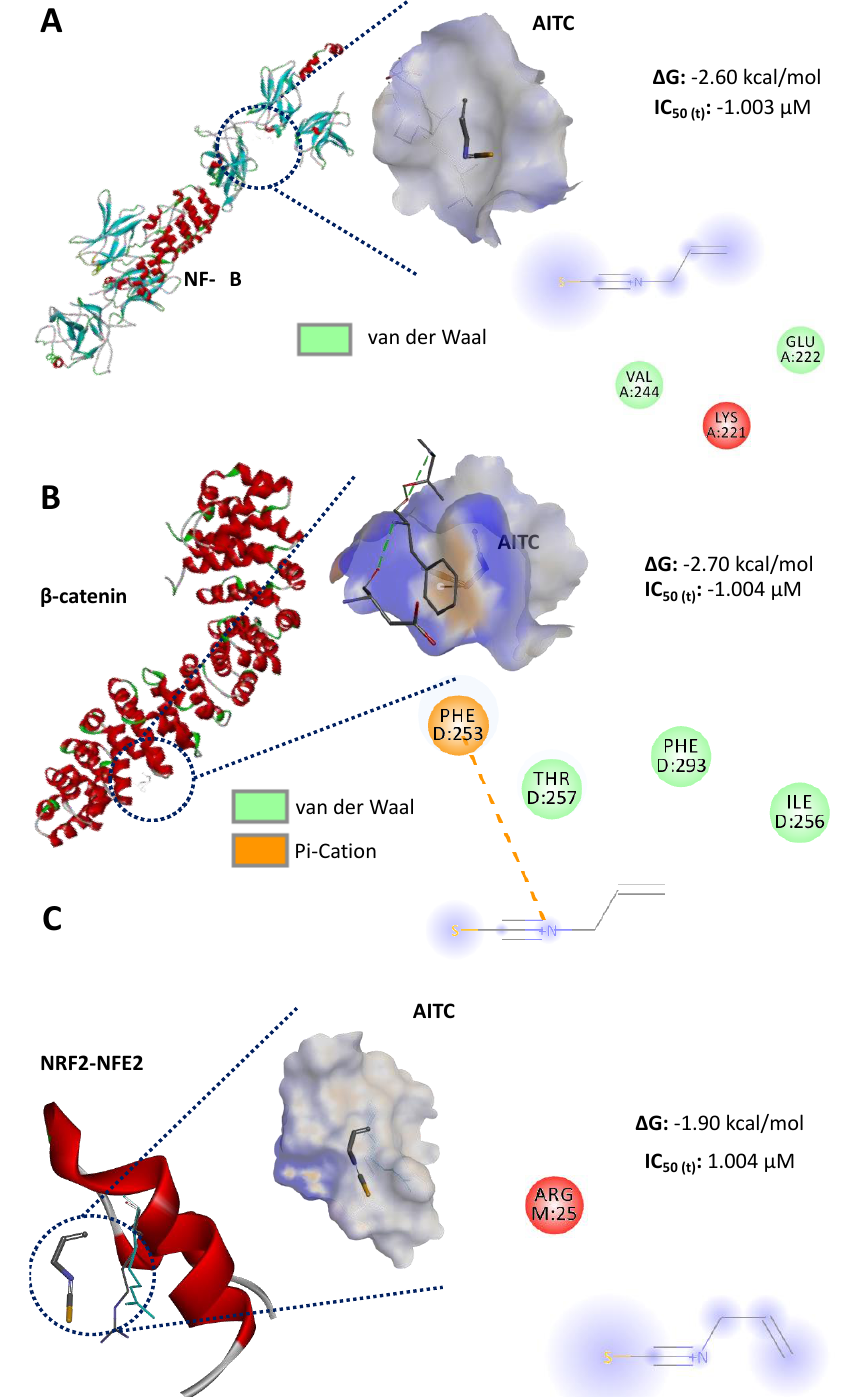
Figure 5. In silico inhibition evaluation of the binding affinity between allyl isothiocyanate (AITC) and molecular targets of colorectal cancer. ( A ) Binding between AITC and nuclear factor κ B (NF- κ B); ( B ) binding between AITC and β -catenin; ( C ) binding between AITC and NRF2-NFE2. ∆ G: Gibbs free energy; IC 50 (t) : theoretical half-inhibitory concentration (calculated using ∆ G).